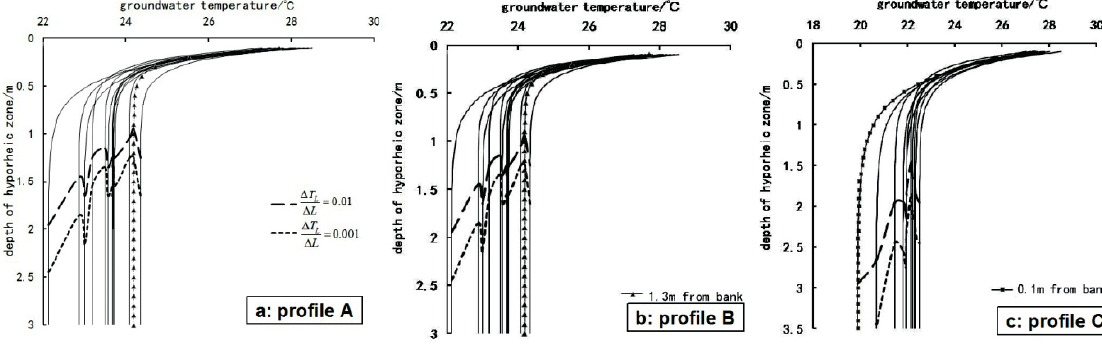
Fig. 6 Hyporheic zone depths and groundwater temperatures relation